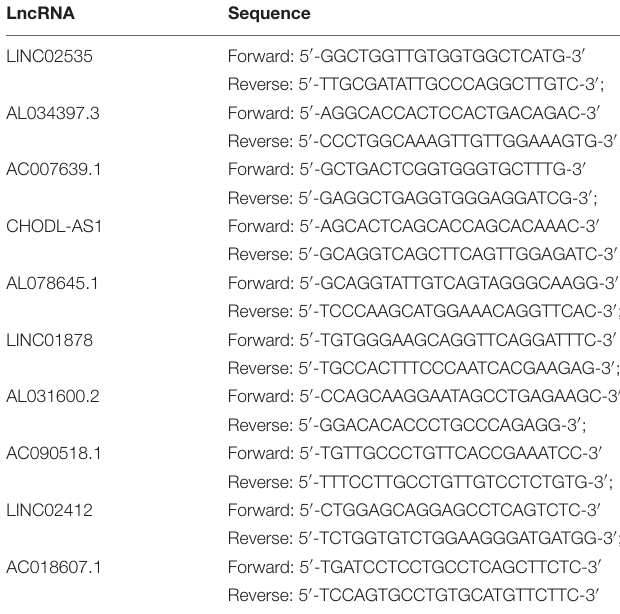
TABLE 1 | qRT-PCR primer